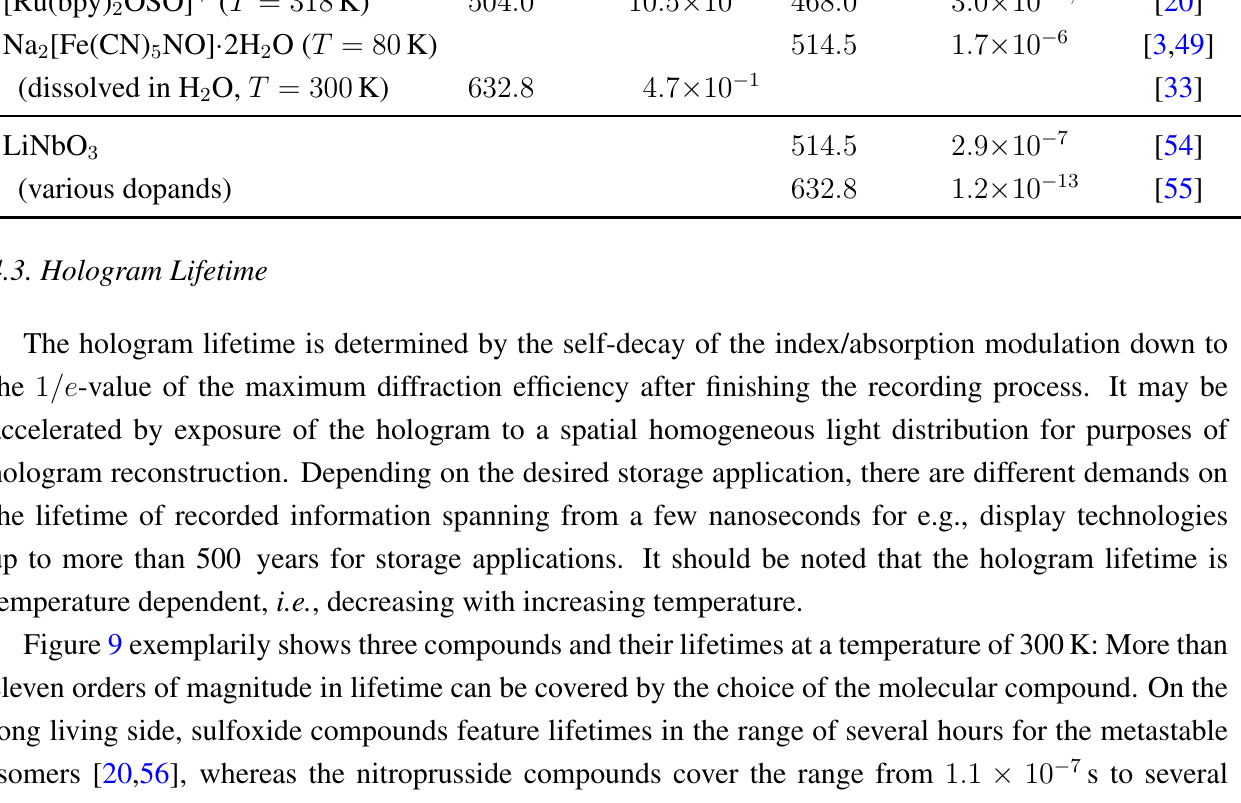
for SNP and OSO at n